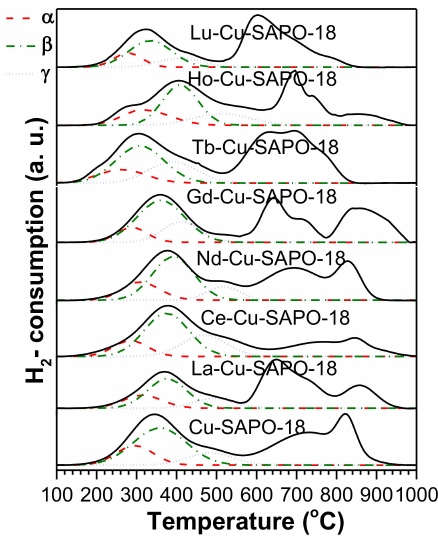
Figure 8. H 2 -TPR profiles of the fresh samples.